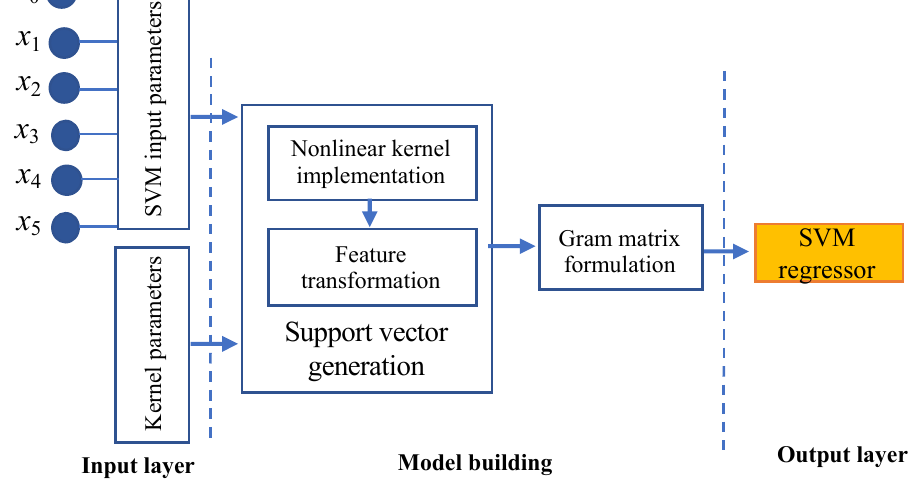
Figure 6. Architecture of support vector regression (SVR).